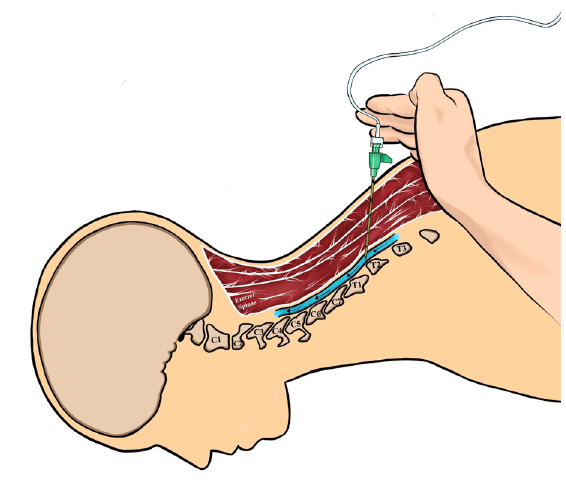
Figure. Depiction of manual compression during injection of anesthetic as well as the cephalad orientation of the needle. Black arrows indicate the direction of injectate flow (Illustration by Elizabeth